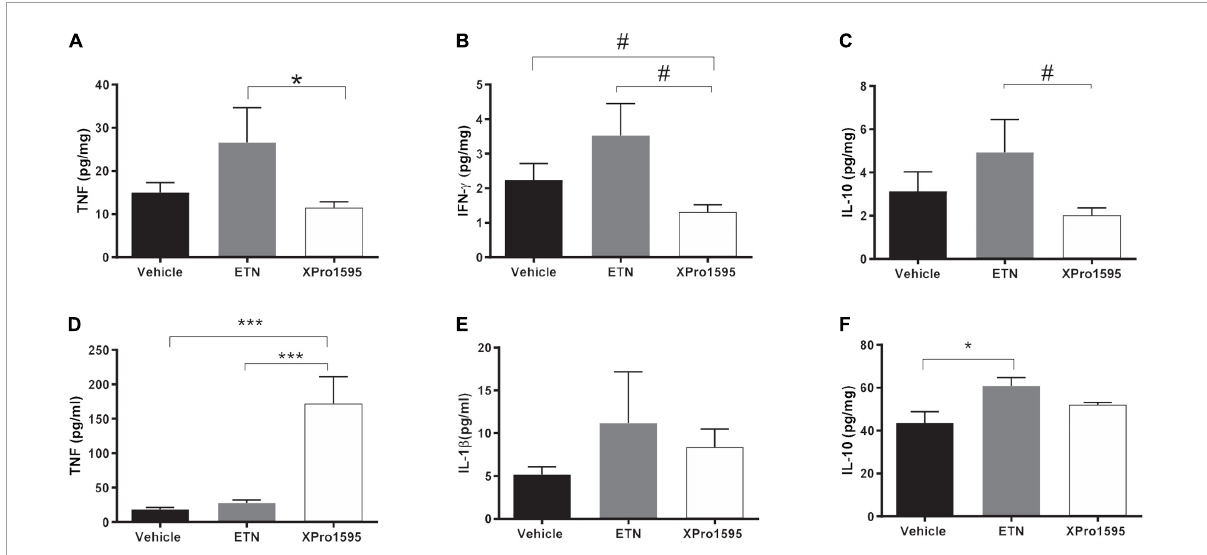
FIGURE4 Pro- and anti-inflammatory cytokine profile systemically or locally produced in PPE-induced aneurysms after TNF inhibition. Changes in aneurysmal cytokine levels of TNF ( n = 5–8) (A) , IFN- γ ( n = 6–8) (B) , and IL-10 ( n = 6–8) (C) 14 days after PPE-induced AAA mice treated with vehicle (saline), ETN (20 mg/kg), or XPro1595 (20 mg/kg). Changes in plasma levels of TNF ( n = 7–8) (D) , IL-1 β ( n = 8) (E) , and IL-10 ( n = 7–8) (F) . Data are shown as mean SEM. No significance was observed by one-way ANOVA using Bonferroni test for multiple comparisons. P -values are denoted * p < 0.05, *** p < 0.001, and # denotes p < 0.05 for unpaired Student’s t -test for two-group comparisons.